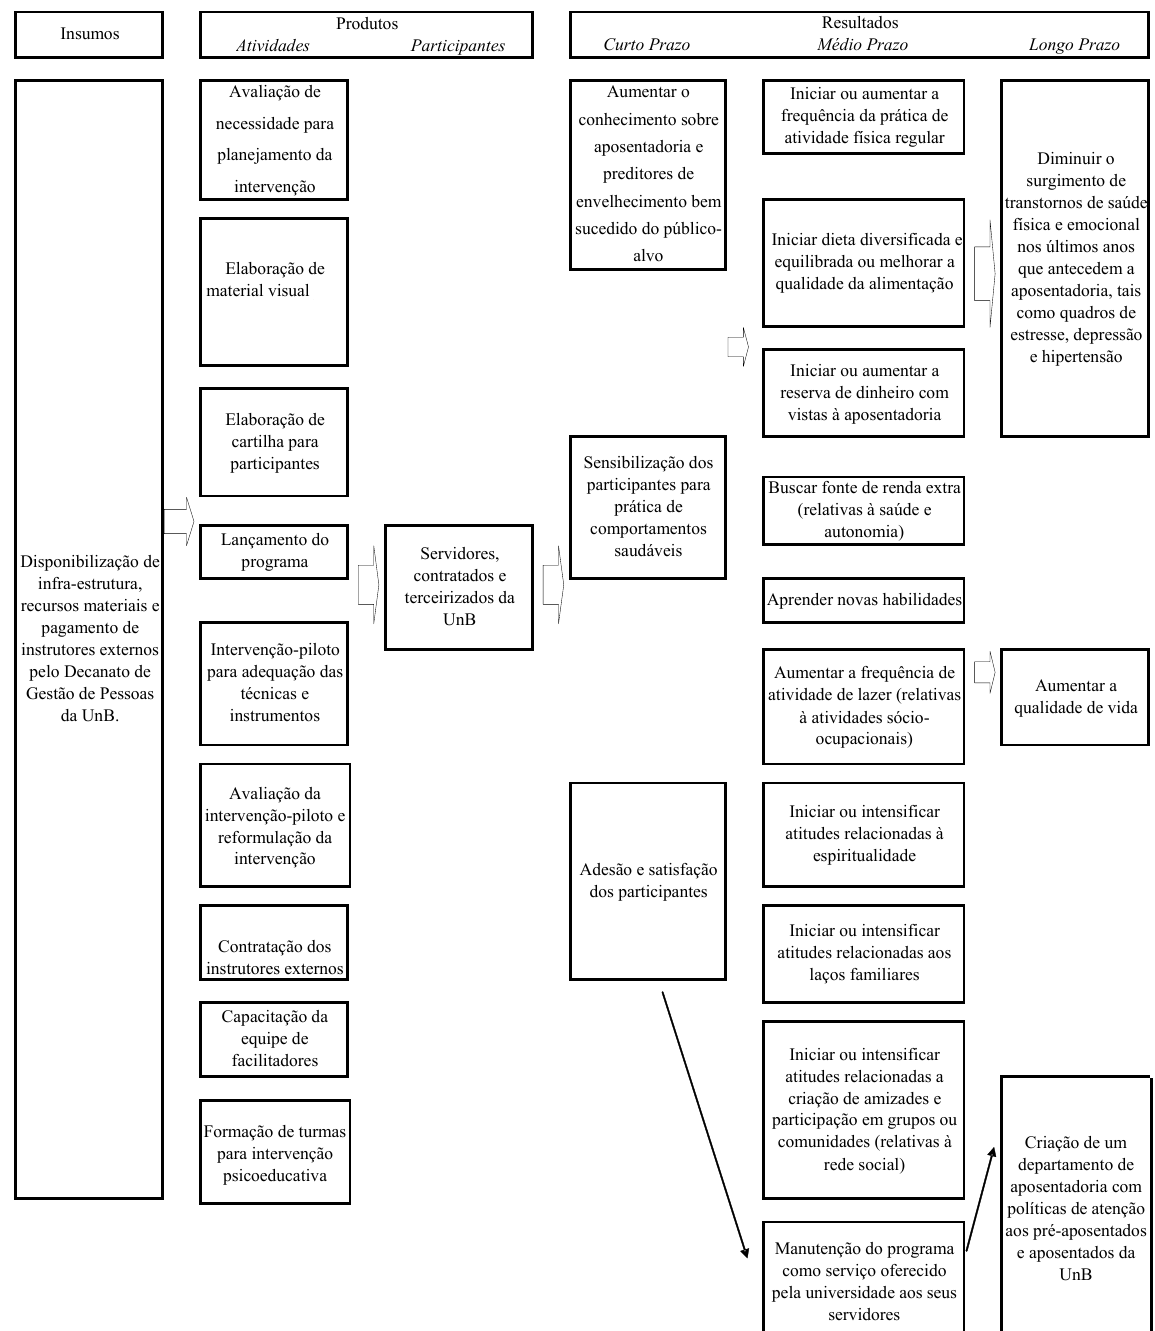
Figura 1 . Modelo Lógico do Programa Viva